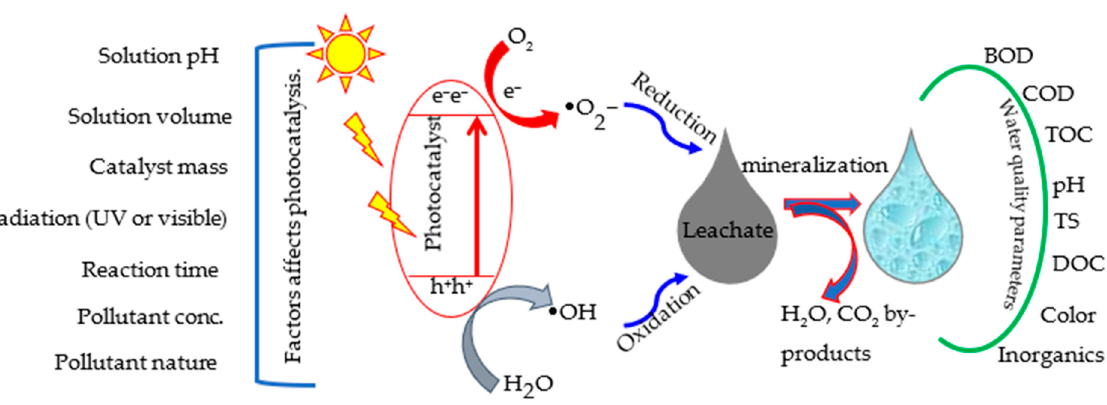
Figure 7. Mechanistic description, experimental and leachate properties affect the photocatalytic